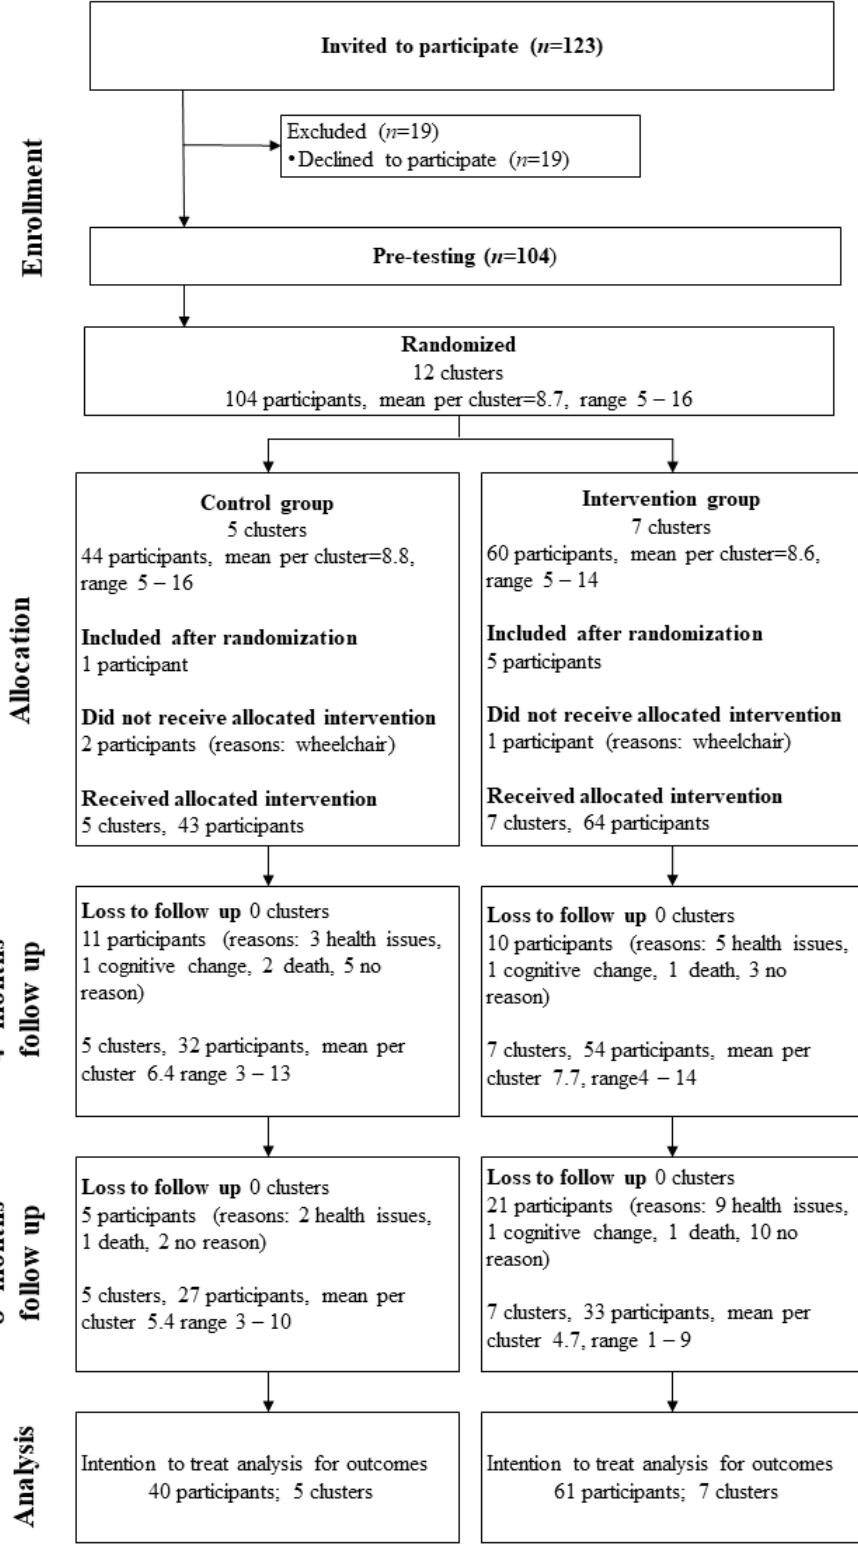
Figure 1. CONSORT (Consolidated Standards of Reporting Trails) flow chart of participant recruit- ment.